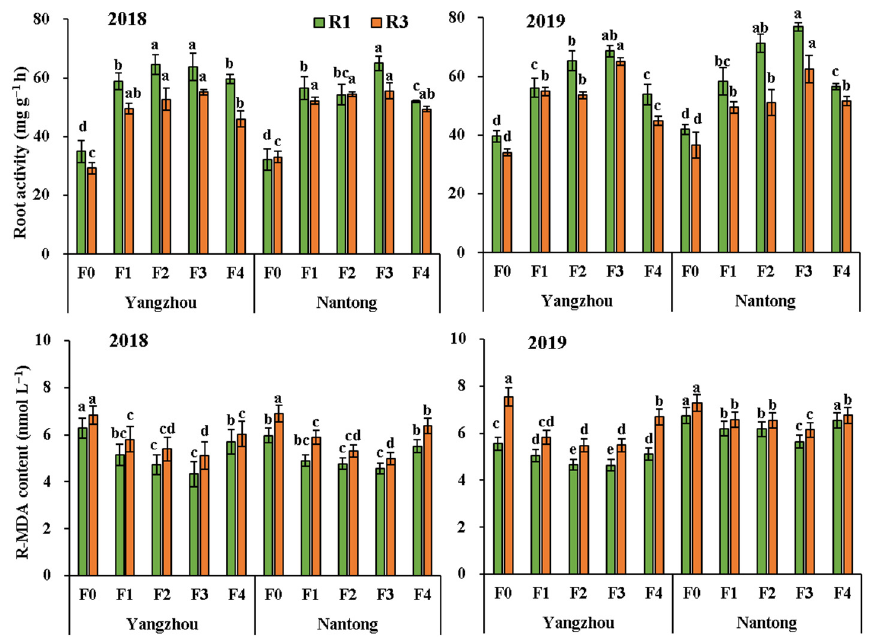
The different letters followed values (means of R1 and R3) within a column mean the difference was significant at p < 0.05 according to Duncan’s Multiple Range Test. F0: no fertilizer; F1, F2, and F3 represent new compound fertilizer applied 225 kg N ha − 1 at sowing, V3, and V6 stages, respectively; F4: applied 75 kg N ha − 1 traditional compound fertilizer at sowing stage and 150 kg N ha − 1 urea at V6 stage. R − NR, R − GOGAT, R − GS, R − MDA, R − SOD, R − POD, and R − CAT represent nitrate reduc- tase, glutamate synthase, glutamine synthetase, malondialdehyde, superoxide dismutase, peroxi- dase, and catalase in root, respectively. * and ** indicated significant difference at the 0.05 and 0.01 levels of probability, respectively.